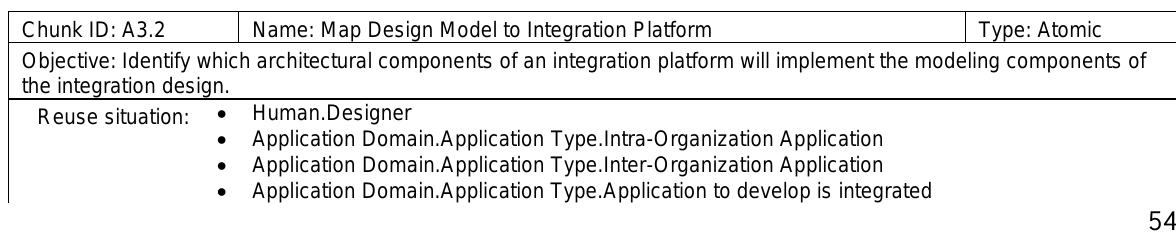
Table 9. Definition of method chunk